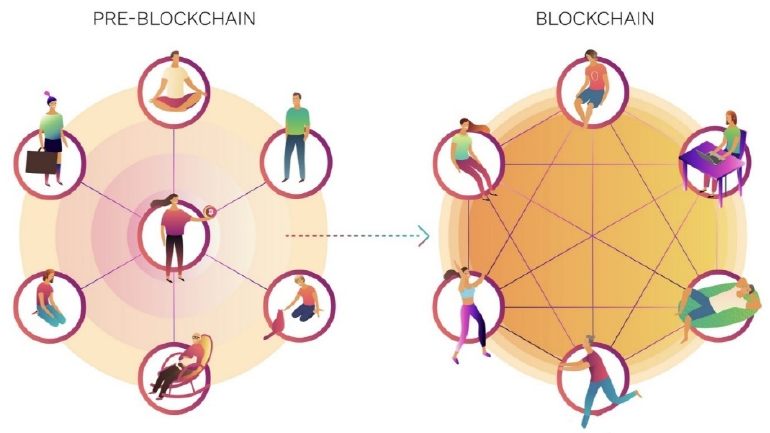
Figure 8. The principle of the central network structure to the P2P network structure.